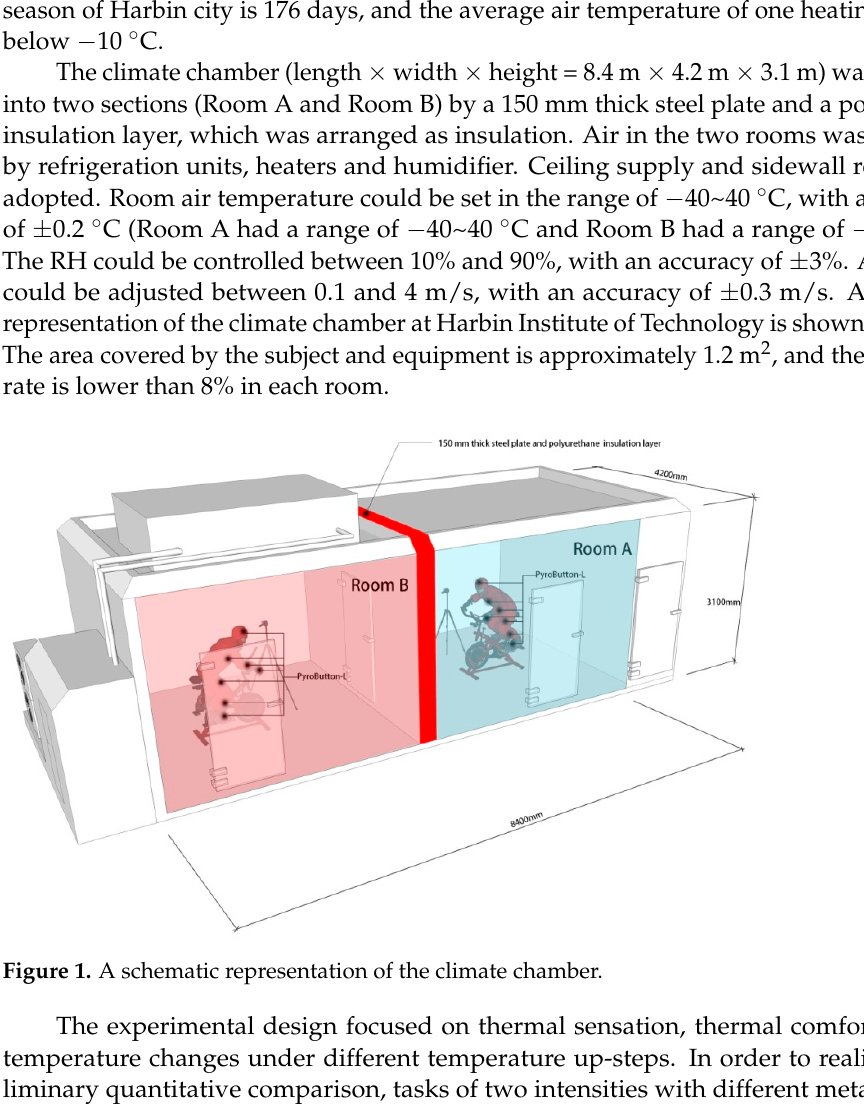
(slowly) are adopted as light activity, which is approximately 1.5 met.